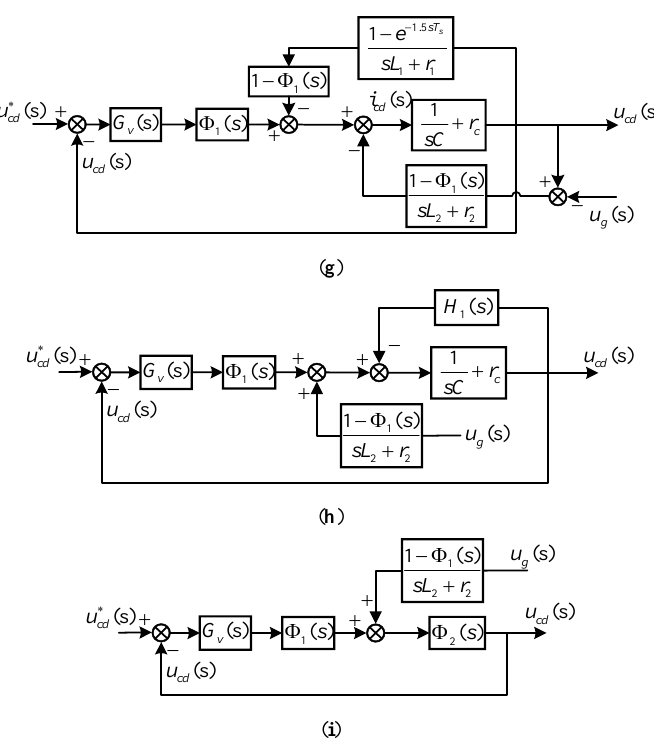
Figure A1. The detailed transformation processes. ( a ) control block diagram of the voltage and current loops in d-axis; ( b ) making the feedforward point of u cd backward; ( c ) making the feedback point of u cd backward; ( d ) exchanging the feedback point and the tapping point; ( e ) simplifying the current loop; ( f ) making the feedforward point of u cd backward; ( g ) selecting u cd as the output of the system; ( h ) combining the inner loops; ( i ) simplifying the voltage loop.